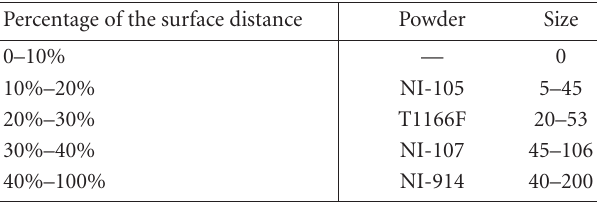
Table 3: Nickel-based powders used on the test airfoil with variable surface roughness on the pressure side.